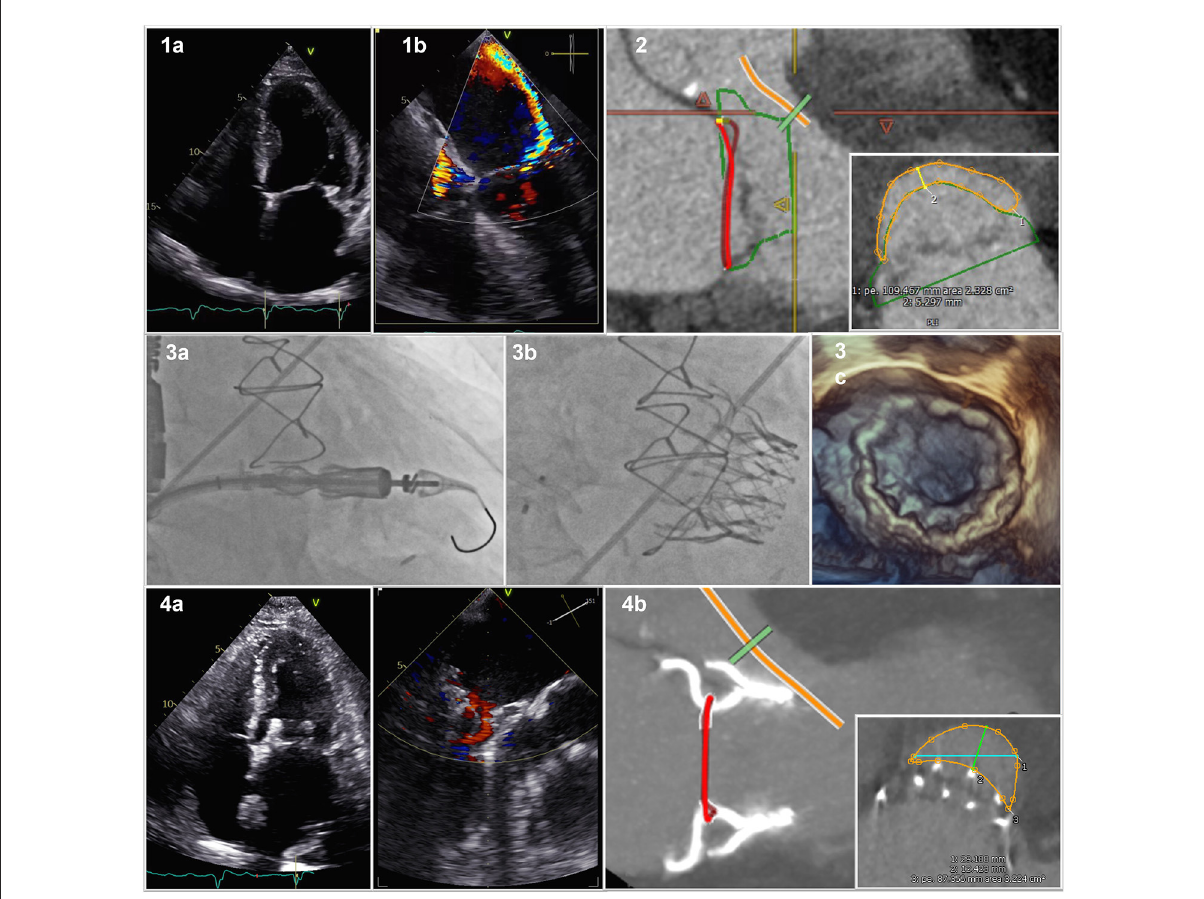
FIGURE1 Cardiovalve in Mitral Valve Position. (1a) 2D posterior mitral leaflet by calcification; (1b) consecutive severe excentric posterior jet; (2) Pre-procedural computed tomography scan with valve sizing and predicted neo-LVOT; (3a) Fluoroscopy of device delivery; (3b) Fluoroscopy of device with closure of ASD; (3c) 3D transesophageal echocardiography of delivered Device; (4a) post-interventional result; (4b) Post-procedural CT scan with actual